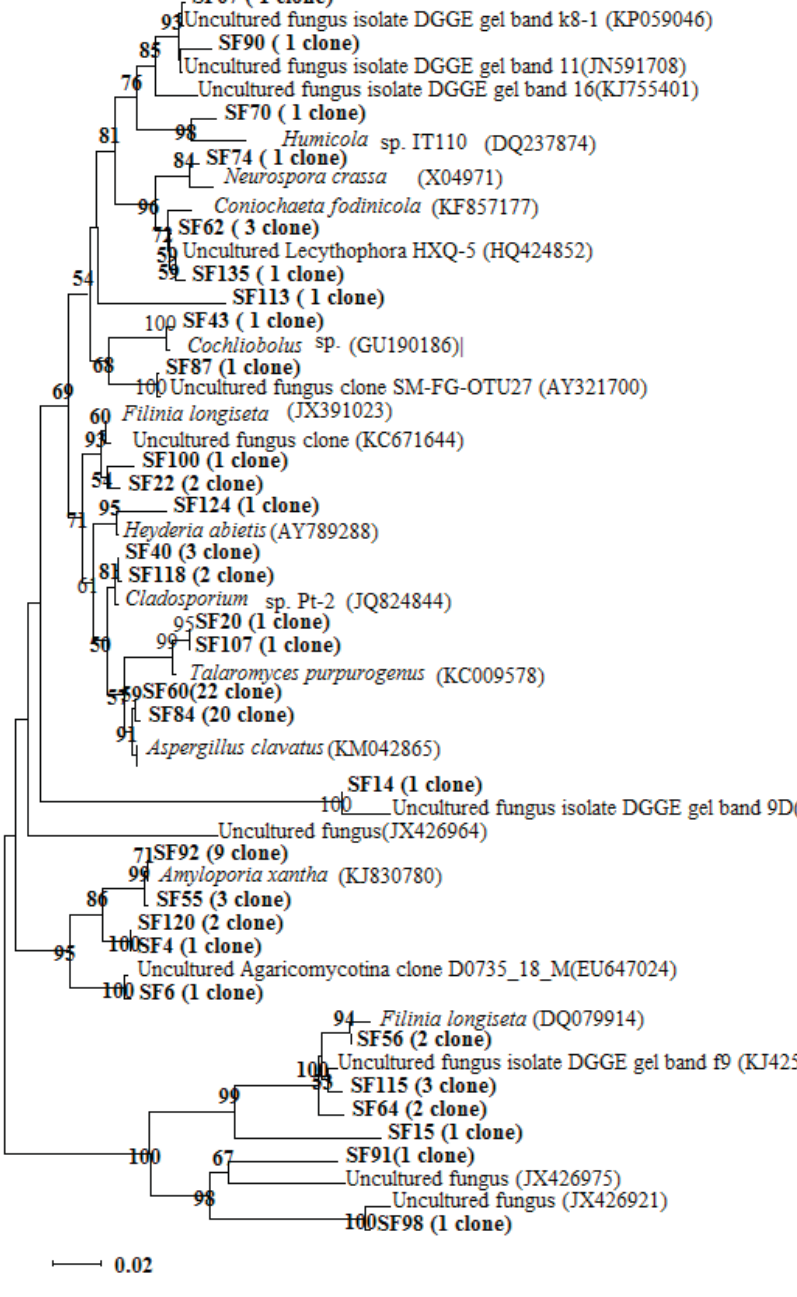
Figure 3. Neighbor-joining phylogenetic tree based on 18S rRNA gene sequences based on the representative clone of each Operational Taxonomic Units (OTU) (cutoff = 0.03) of Seagrass Fungi (SF) clone library Numbers in parentheses indicate clones in each OUT. Bootstrap analysis was based on 1000 replicates. Bootstrap values from distance analysis are depicted. Bootstrap values less than 50% are not